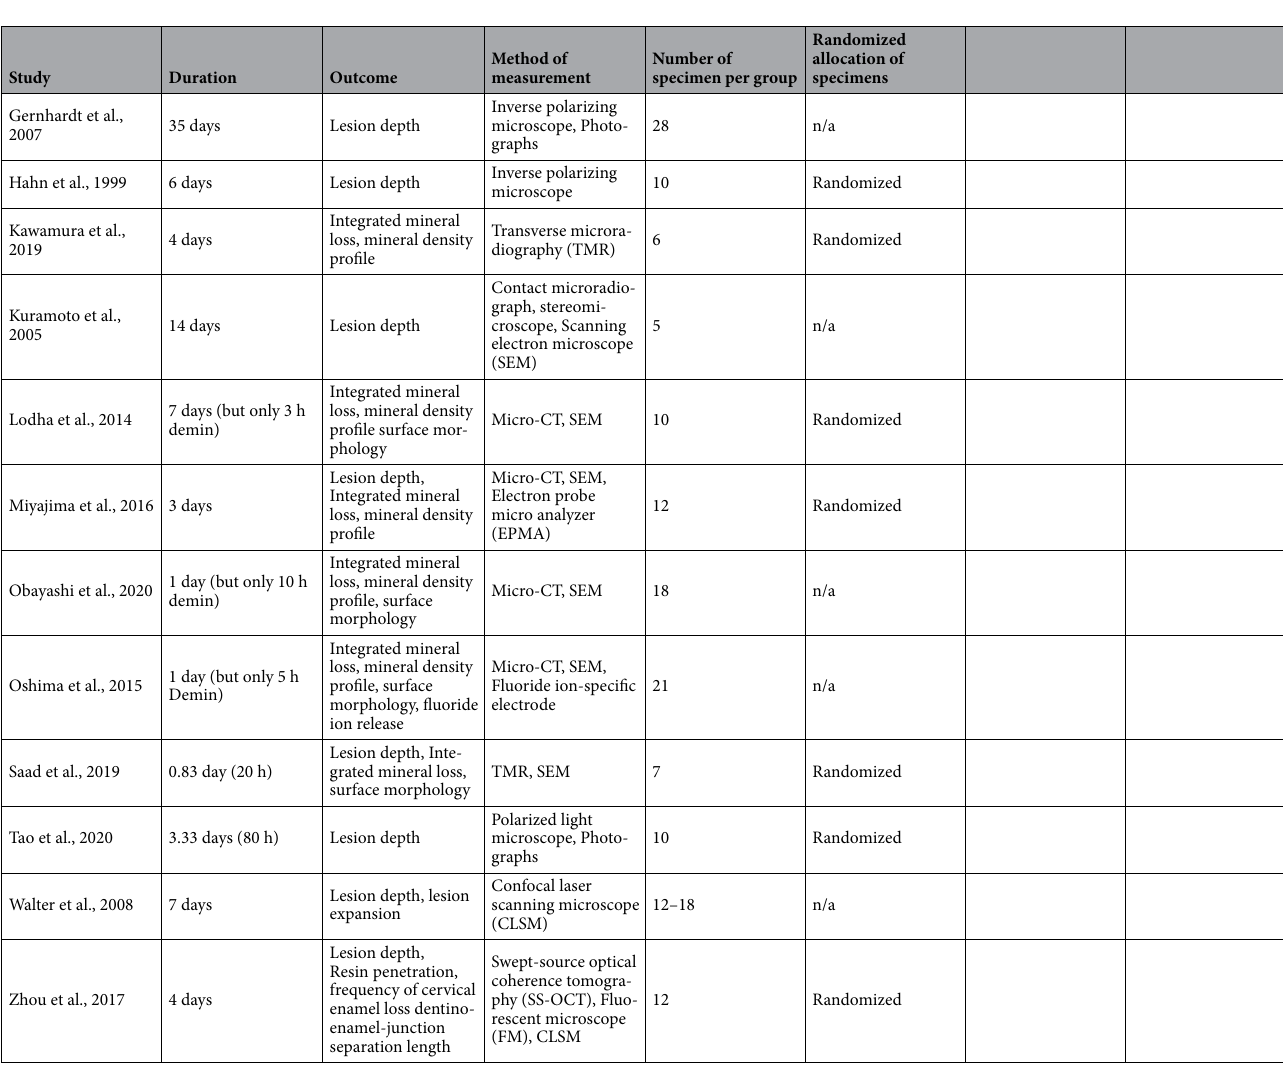
Table 2. Detailed summary of included